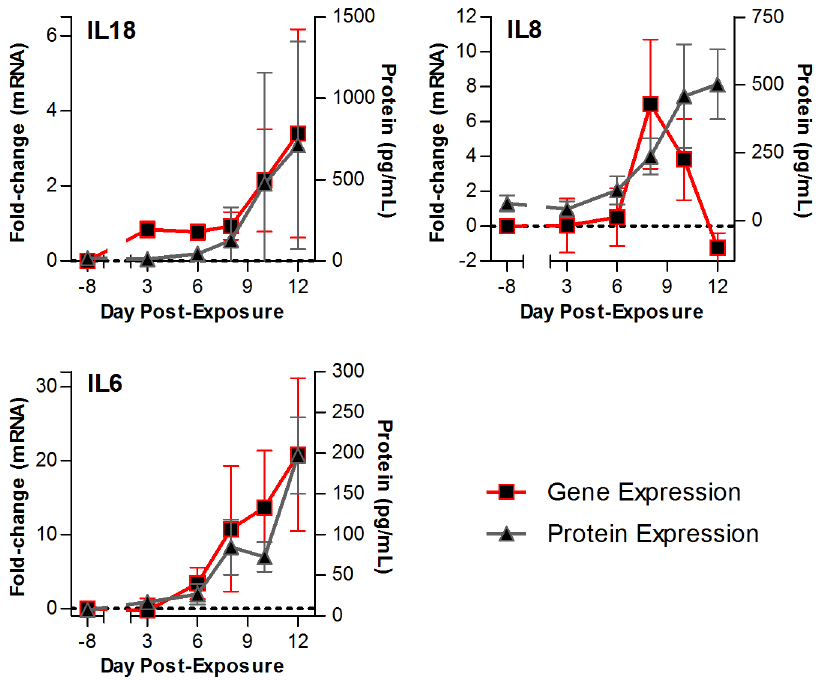
Figure 6. Comparison of the cytokine gene expression with the cytokine levels in the plasma of LASV-exposed NHPs. Line graph to show the comparison of gene expression (red line) to the amount of cytokine detected (in pg/mL, grey line) in the plasma of LASV-exposed NHPs over the course of the disease. Shown here are probes for IL18 (top left panel), IL8 (top right panel), and IL6 (bottom left panel). Error bars represent S.E.